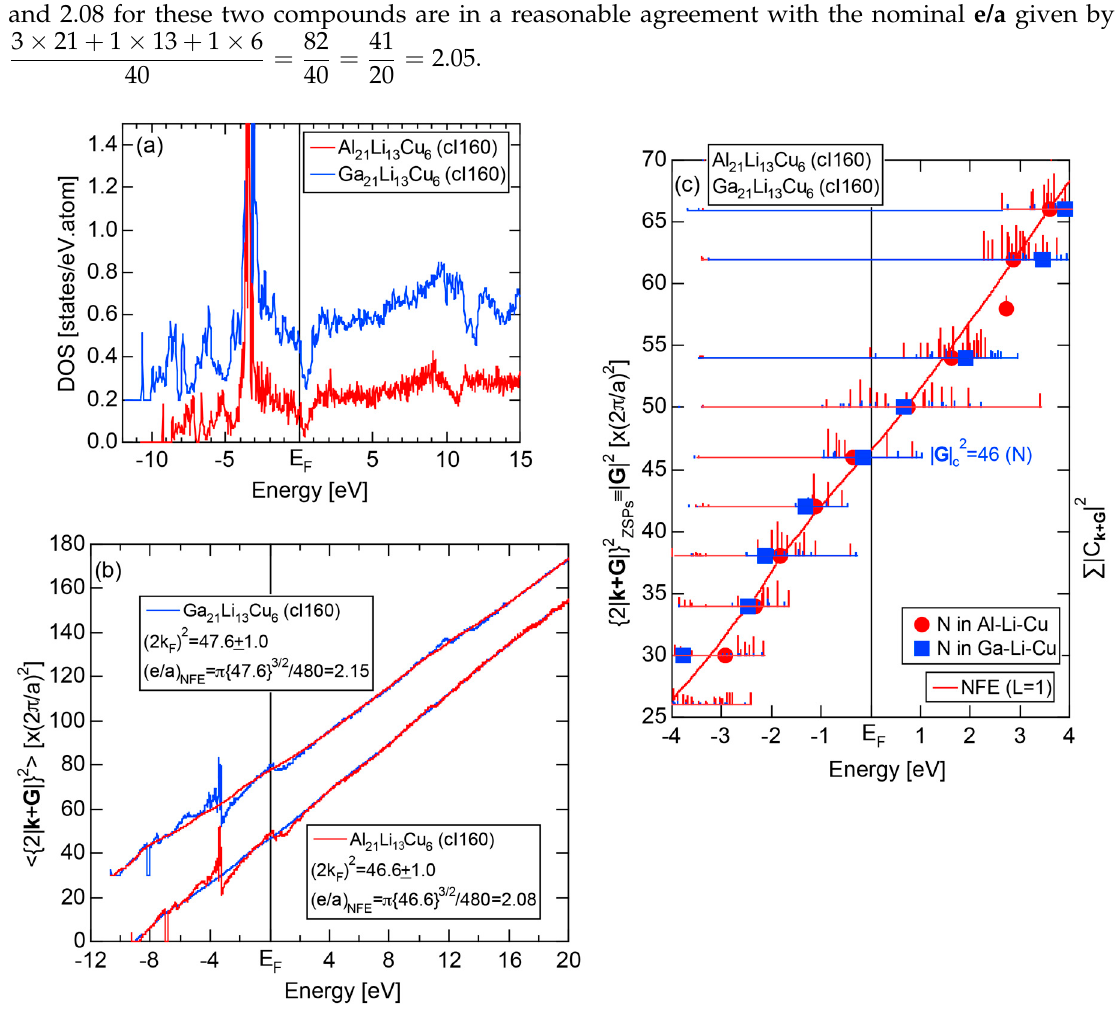
Figure 40. ( a ) Total DOSs; ( b ) Hume-Rothery plots and ( c ) FLAPW-Fourier spectra at symmetry points N of the bcc Brillouin zone for Al 21 Li 13 Cu 6 (cI160) (red) and Ga 21 Li 13 Cu 6 (cI160) (blue).